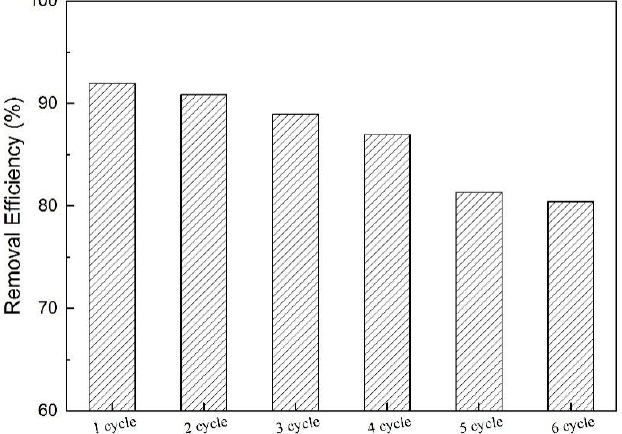
Figure 14. Recyclability of N-GLPs 750 6 for six cycles.